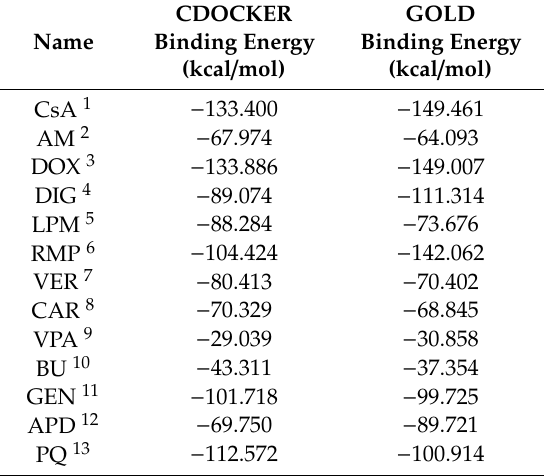
Table 16. Estimate of the overall binding free energies of some well-known substrates and inhibitors of P-gp using the experimentally solved cryo–electron microscopy structure of h P-gp (PDB ID: 6QEX).